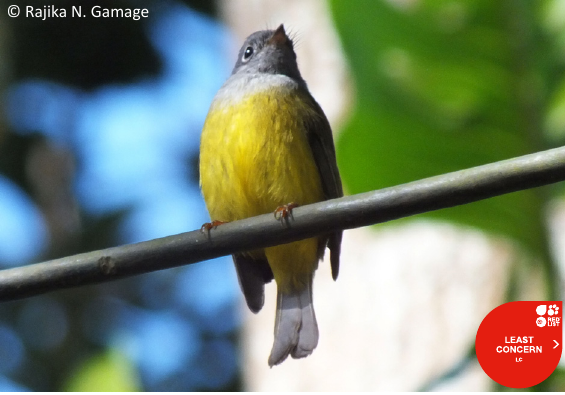
Image 9. Pompadour Green Pigeon Treron pompadora